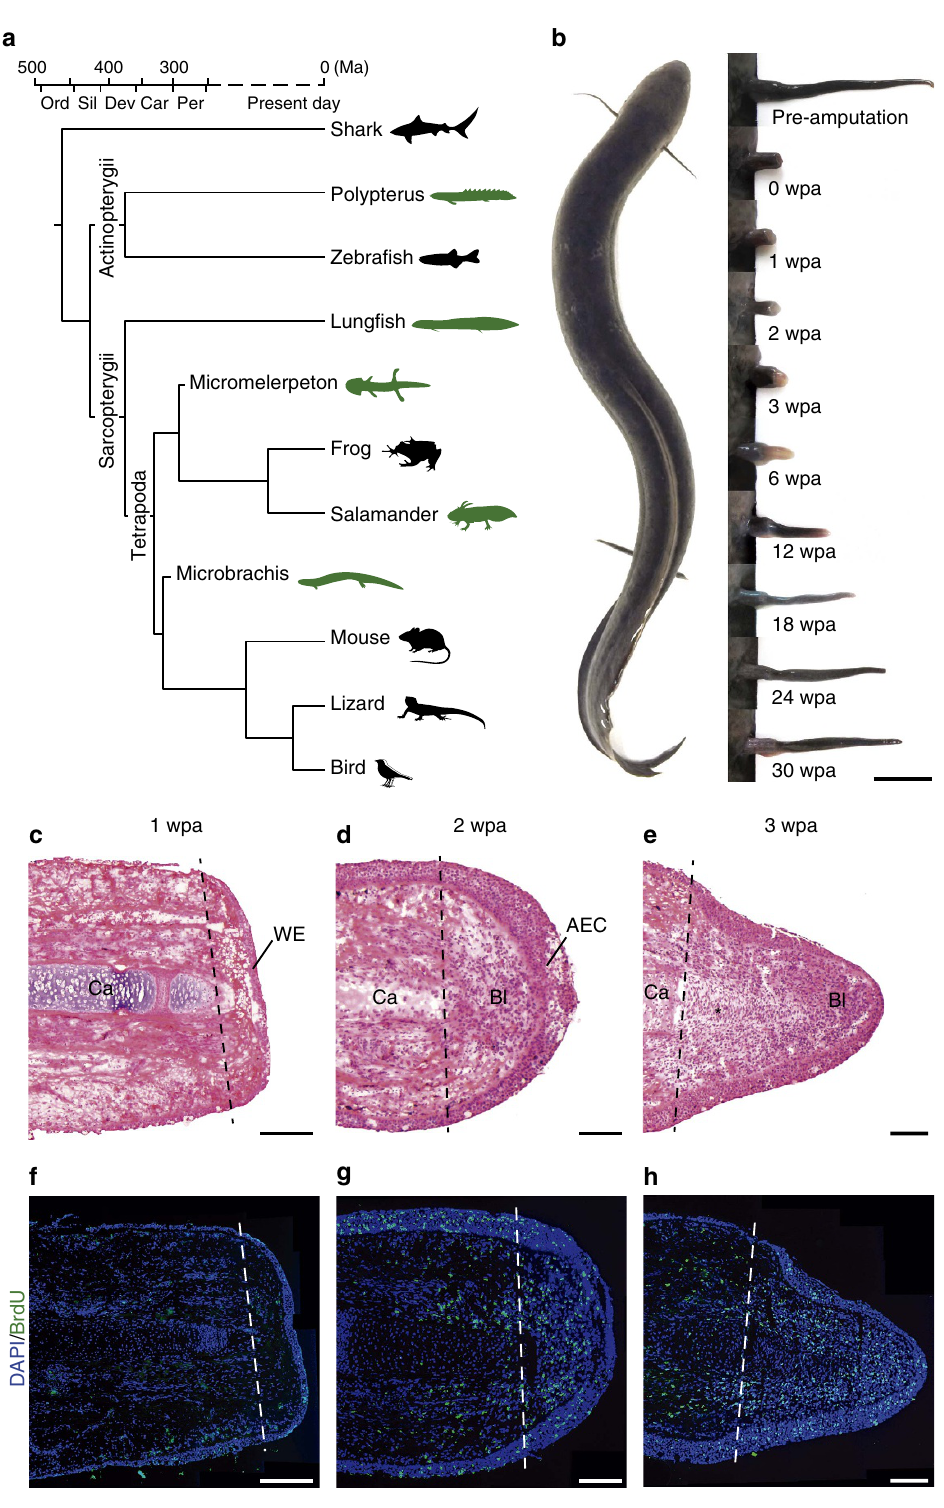
Figure 1 | Fin regeneration and blastema formation in the L. paradoxa . ( a ) Vertebrate phylogenetic tree, highlighting in green extant and extinct taxonomic groups capable of complete appendage regeneration among actinopterygians ( Polypterus ), sarcopterygian fish (lungfish) and tetrapods (salamanders, Micromelerpeton and Microbrachis ). ( b ) Pectoral fin regeneration monitored for 30 wpa in an adult L. paradoxa specimen. ( c , f ) At 1 wpa, formation of a WE occurs with minimal mitosis. ( d , g ) At 2 wpa, AEC forms and cells accumulate distally and form a blastema, cell proliferation occurs in regions flanking the cartilage and in the blastema. ( e , h ) At 3wpa, blastema extends distally, new cartilage is forming and cell proliferation intensifies. Haematoxylin and eosin stained sections are shown ( c – e ). Proliferating cells during fin regeneration are shown (green), the nuclei of all cells is stained (blue) ( f – h ). Dashed lines denote amputation planes. Asterisk denotes newly formed cartilage. Scale bars of 10mm ( b ), 1mm ( c , f ) and 0.5mm ( d , e , g , h ). Ca, cartilage; Bl, blastema; Ma, million years